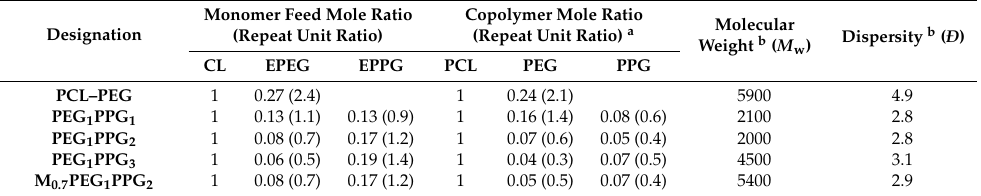
Table 1. Initial monomer feed mole ratios used in the synthesis of the copolymers and characterisation of the copolymer composition and molecular